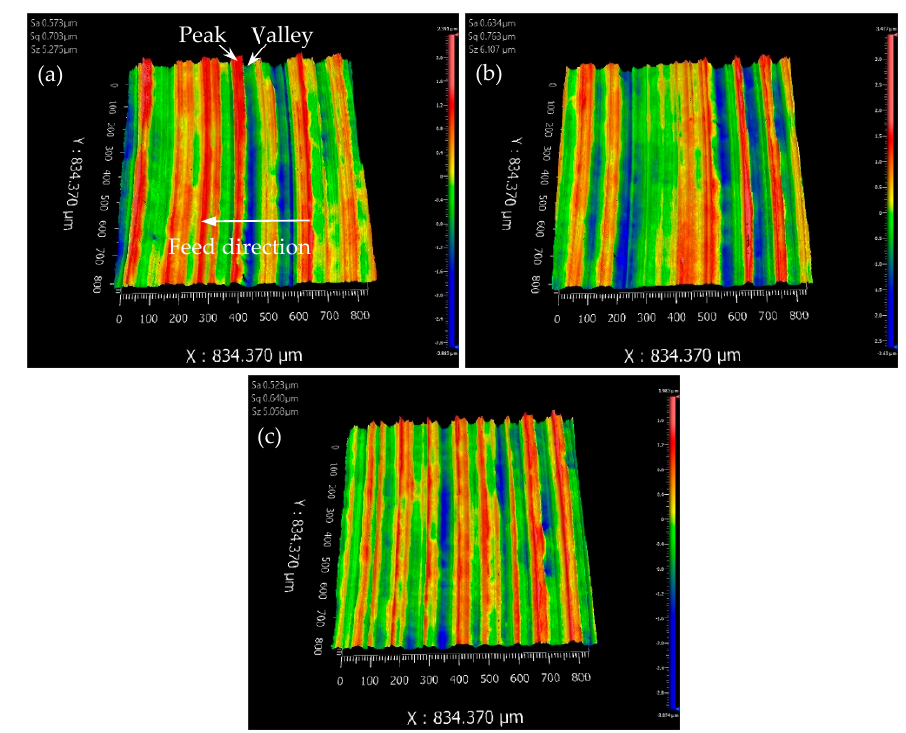
Figure 4. The images of the areal surface roughness of the verified sample 10: ( a ), ( b ), and ( c ) is from the first, the second and the third sampling area, respectively.